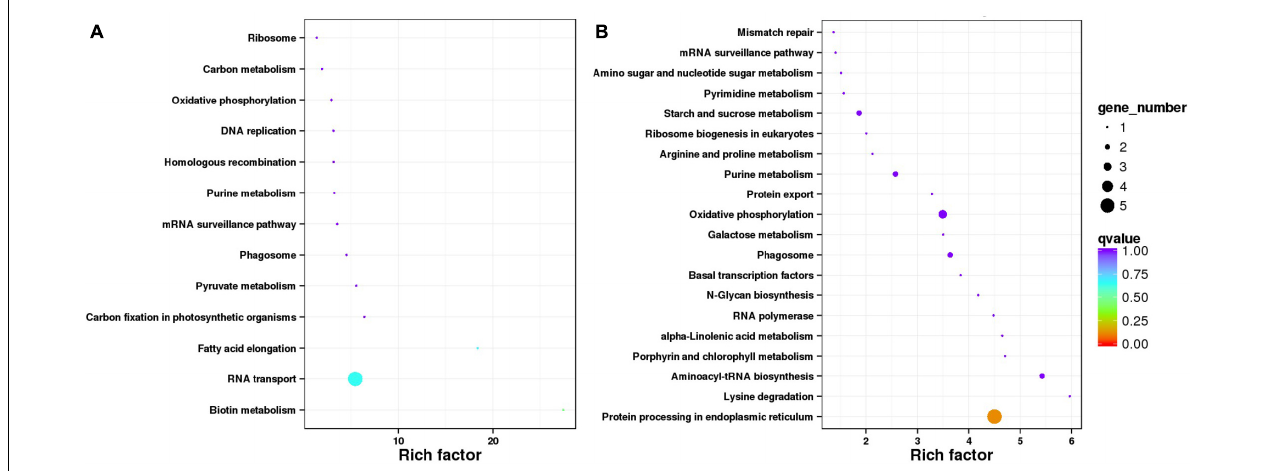
FIGURE 3 | Statistics of Kyoto Encyclopedia of Genes and Genomes pathway enrichment for two classifications of differentially expressed genes (DEGs). (A) Data for 33 stable DEGs representing same or similar expression trends in both environments. (B) Data for 96 environment-specific DEGs showing different expression trends from Xindu to